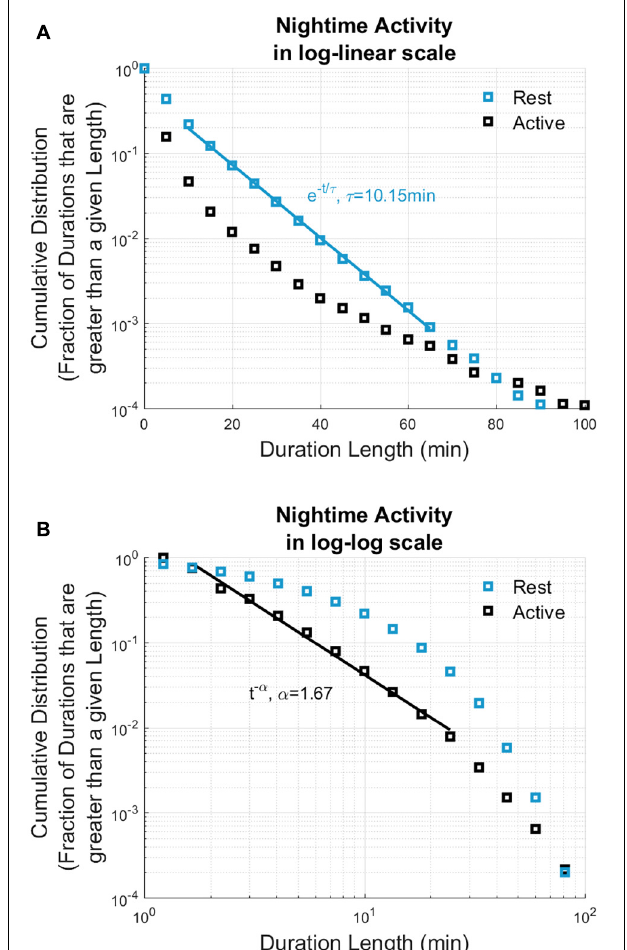
FIGURE 2 | Cumulative distribution of rest and active durations based on 14,736 h of nighttime actigraphy data recorded from all participated patients ( n = 22). The cumulative distributions of nighttime rest periods (displayed in blue) show exponential distribution, whereas active periods (displayed in black) show power law distribution. Solid lines show the best straight-line fits: rest durations can be fitted by a straight line in log-linear scale (A) , and active durations can be fitted with a straight line in log-log scale (B) . X axis display the nighttime durations; Y axis show the cumulative distributions. The current actigraphy data analysis revealed similar nighttime rest/activity dynamics to nighttime sleep/wake dynamics based on polysomnography data analysis (Lo et al.,